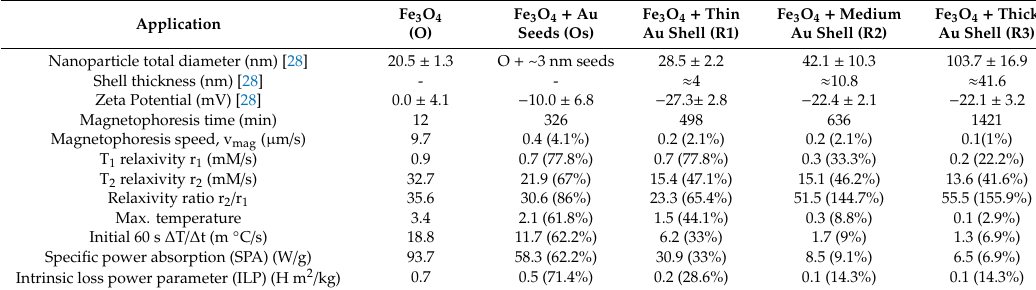
Figure 2. ( A ) The experimental setup to monitor the magnetophoretic behavior, using a white light source and spectrometer to monitor the diffusion of the nanoparticles to a permanent magnet. ( B ) The distance-dependent magnetic flux density of the permanent magnet used in this experiment, with the dashed line representing the probe height. ( C ) The magnetophoresis of the various stages of the magnetic-plasmonic nanoparticles. On the vertical axis, 1 represents the starting concentration of 20 μ g/mL of Fe 3 O 4 . The data are extrapolated to estimate the time for total magnetophoresis out of the probed area. Table 1. Overview of the key findings in this work for the five stages of nanoparticle. Percentages in brackets indicate the percentage as compared to the uncoated iron oxide nanoparticle.